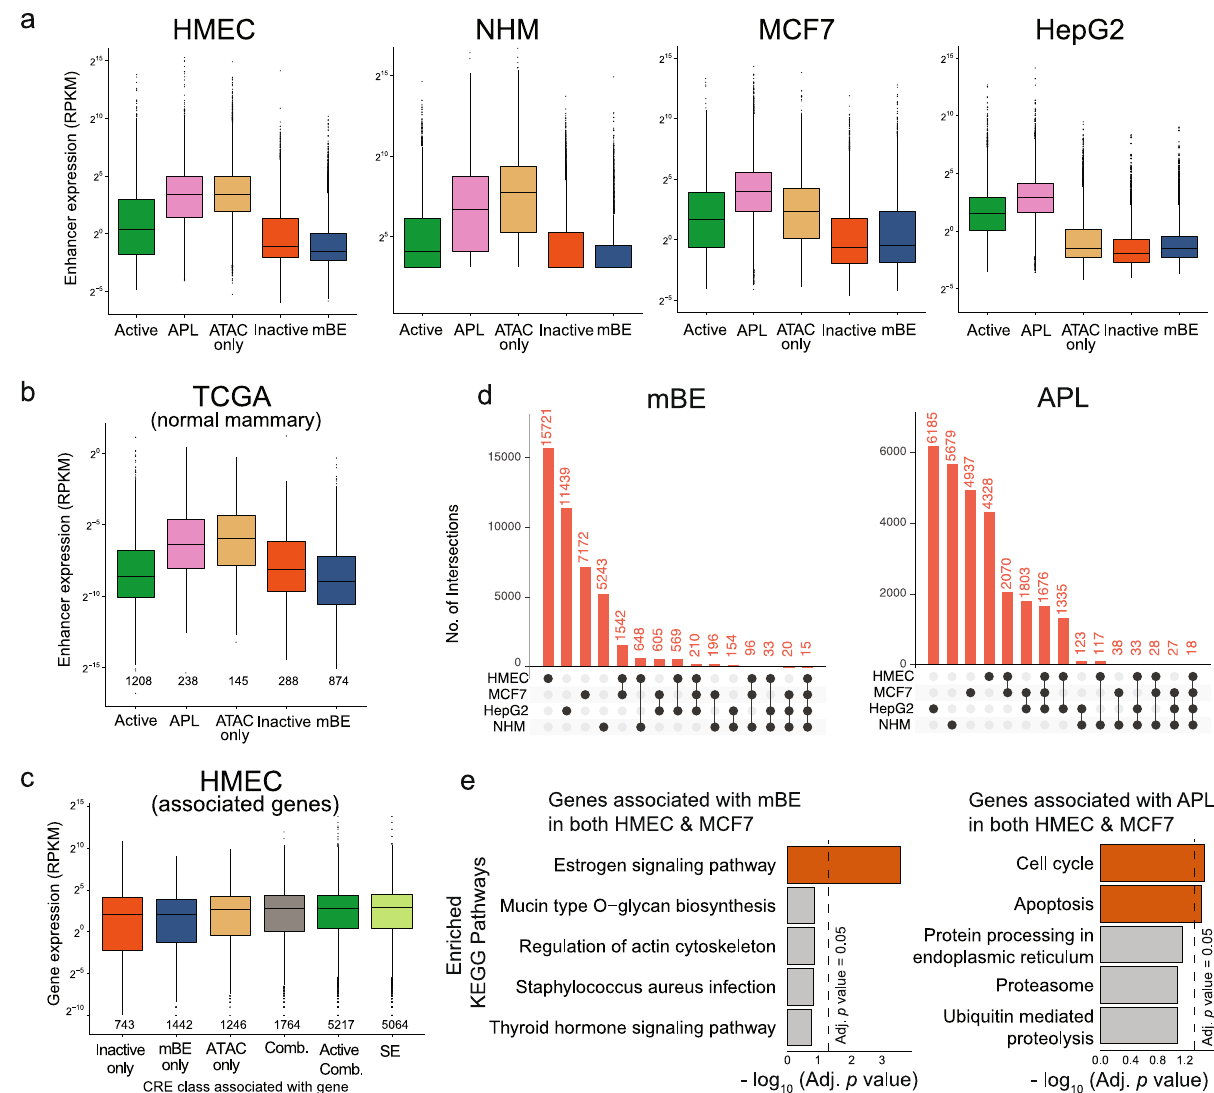
Fig. 2 MacroH2A regulates enhancer activity. a Expression levels at the CRE grouped by the fi ve classes in human mammary epithelial cells (HMEC), normal human melanocytes (NHM), the breast cancer cell line (MCF7) and the human hepatocellular carcinoma cell line (HepG2) quanti fi ed by RNA-seq data from ENCODE reference epigenome for HMEC (total), MCF7 (poly-A) and HepG2 (total), and from Fontanals-Cirera et al. 73 for NHM (total). The number of datapoints, n , equals the number of CRE per class shown in Fig. 1c. b Expression levels by RNA-seq from normal breast samples (averaged across 113 samples) from TCGA 35 at enhancers that overlap the annotated CRE in HMEC. The number of datapoints, n , is shown below each box. c Expression levels by RNA-seq from Roadmap reference epigenome (E119) at protein-coding genes directly associated with the CRE from HMEC (associations obtained from GeneHancer) and super-enhancers (annotated using LILY). Inactive only , mBE only and ATAC only : genes associated with only Inactive, mBE or ATAC only classes of CRE respectively; Active Comb : genes associated with at least one Active CRE and possibly other combination of CRE classes; Comb : genes associated with all other combinations of CRE classes; SE : genes associated with those CRE identi fi ed as super-enhancers. The number of datapoints, n , is shown below each box. The expression data is represented as boxplots where the middle line represents the median, the lower and upper edges of the rectangle represent the fi rst and third quartiles and the lower and upper whiskers represent the interquartile range (IQR) × 1.5. Outliers beyond the end of the whiskers are plotted individually. d Upset plots showing the intersection of mBE and APL (Active Promoter-Like) CRE loci between the four cell lines. e Top 5 most signi fi cant KEGG pathways sorted by Benjamini-Hochberg adjusted p -value of the minimum hypergeometric (mHG) test performed by Cistrome-GO on genes associated with mBE and APL (Active Promoter-Like) common in HMEC and